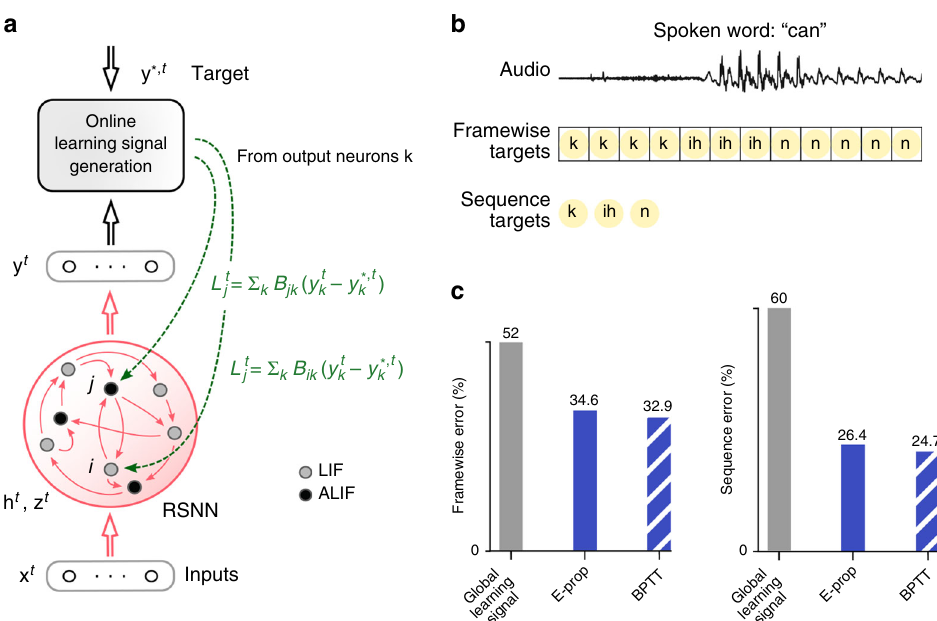
Fig. 2 Comparison of BPTT and e-prop for learning phoneme recognition. a Network architecture for e-prop, illustrated for an LSNN consisting of LIF and ALIF neurons. b Input and target output for the two versions of TIMIT. c Performance of BPTT and symmetric e-prop for LSNNs consisting of 800 neurons for framewise targets and 2400 for sequence targets (random and adaptive e-prop produced similar results, see Supplementary Fig. 2). To obtain the Global learning signal baselines, the neuron-speci fi c feedbacks are replaced with global